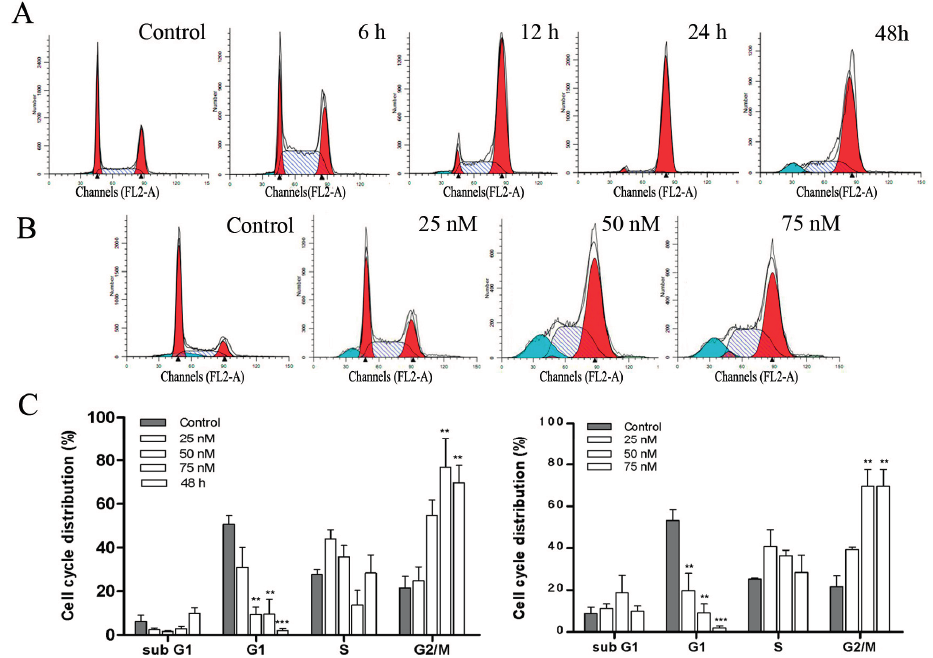
Figure 4. Effect of DPT on cell cycle distribution in SGC-7901 cells. Cell cycle